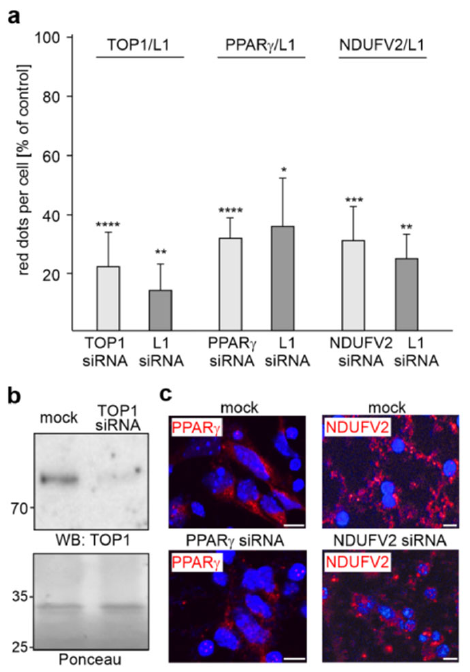
Figure 6. The interaction of L1 with TOP1, PPAR γ or NDUFV2 is reduced by L1, TOP1, PPAR γ and NDUFV2 siRNAs. ( a ) Cultured cortical neurons were mock-transfected or transfected with TOP1, PPAR γ , NDUFV2 or L1 siRNAs. The transfected cells were then subjected to proximity ligation with L1 antibody and antibodies against TOP1, PPAR γ or NDUFV2. Mean values + SD from two experiments are shown for the average numbers of L1/TOP1-, L1/PPAR γ - and L1/NDUFV2-positive red dots per cell relative to control (values of mock-transfected neurons set to